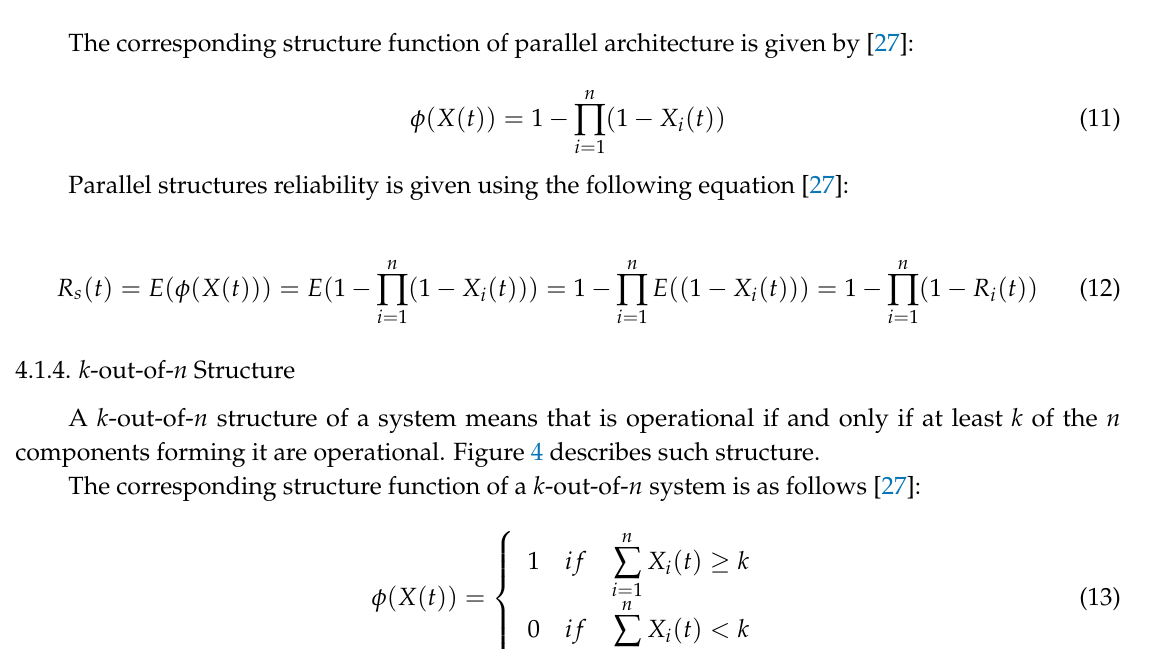
Figure 3. A parallel structure architecture according to the RBD